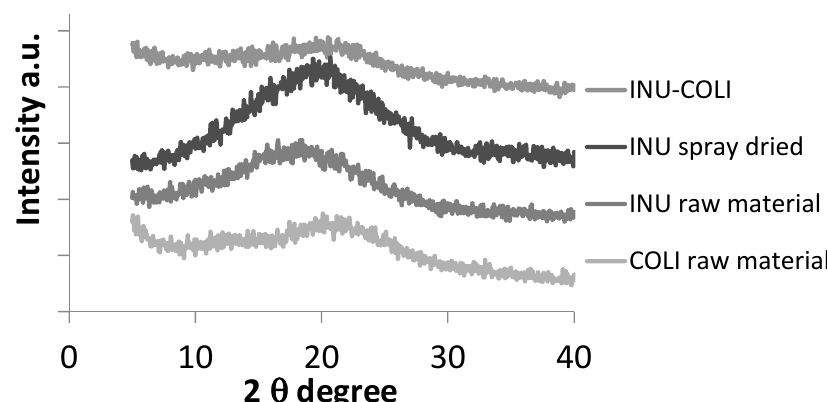
Figure A1. PXRD patterns of the formulations and raw materials. XRD measurements were conducted on samples placed in a low background silicon holder, using a Rigaku Miniflex II desktop X-ray diffractometer (Rigaku, Tokyo, Japan). The samples were scanned over a range of 5–40° 2 θ at a step size of 0.05°/s.